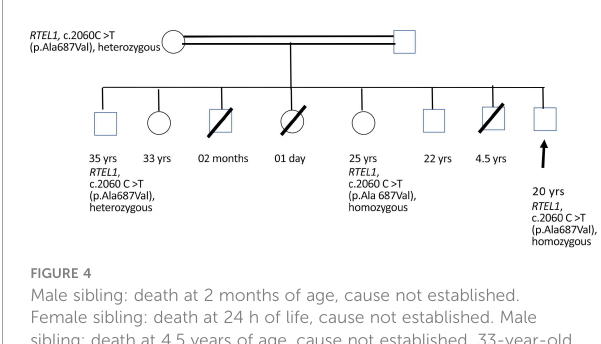
FIGURE 4 Male sibling: death at 2 months of age, cause not established. Female sibling: death at 24 h of life, cause not established. Male sibling: death at 4.5 years of age, cause not established. 33-year-old female sibling: alive and healthy. 22-year-old male sibling: alive and